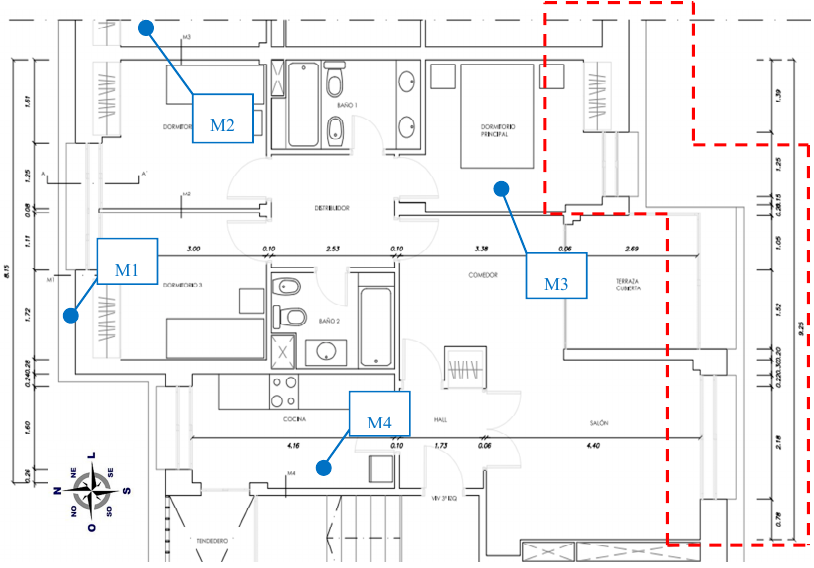
Figure 1. Layout plan and location of different walls.